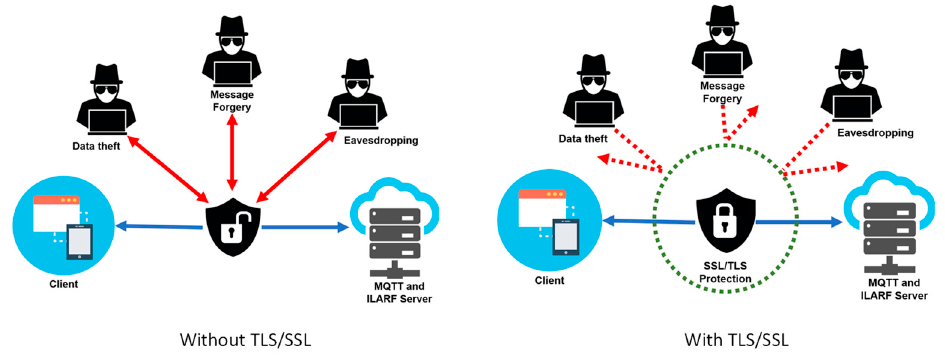
Figure 16. Data communication without (left) and with (right) TLS/SSL.